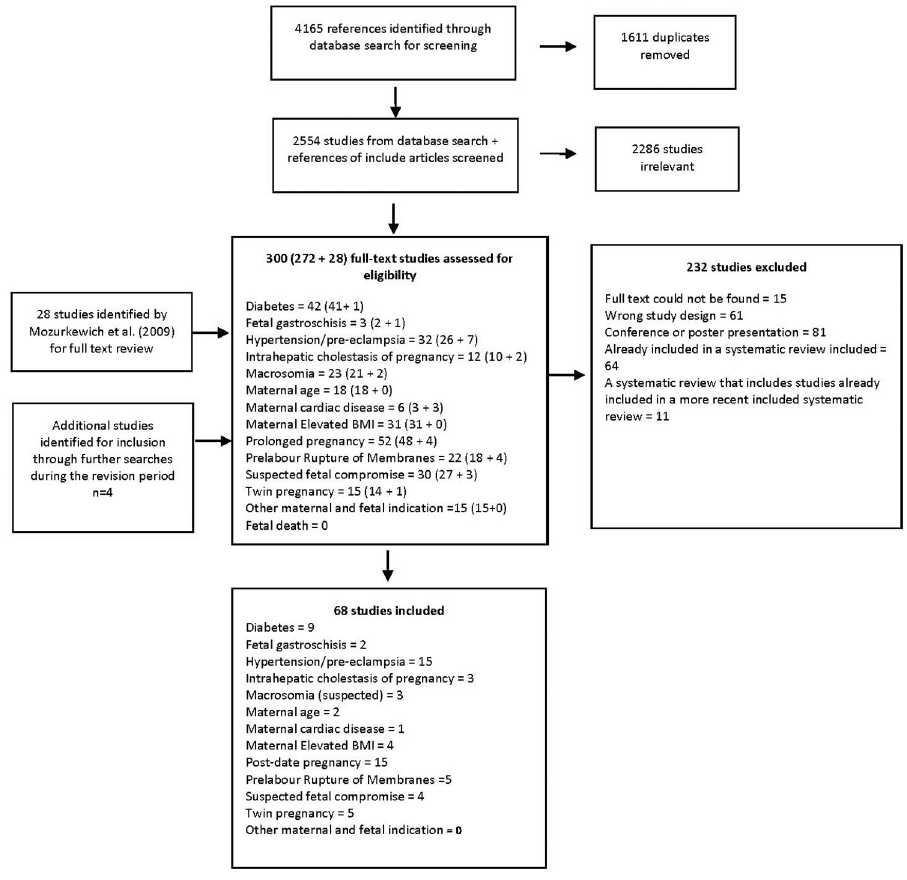
Fig 1. Flow of papers through